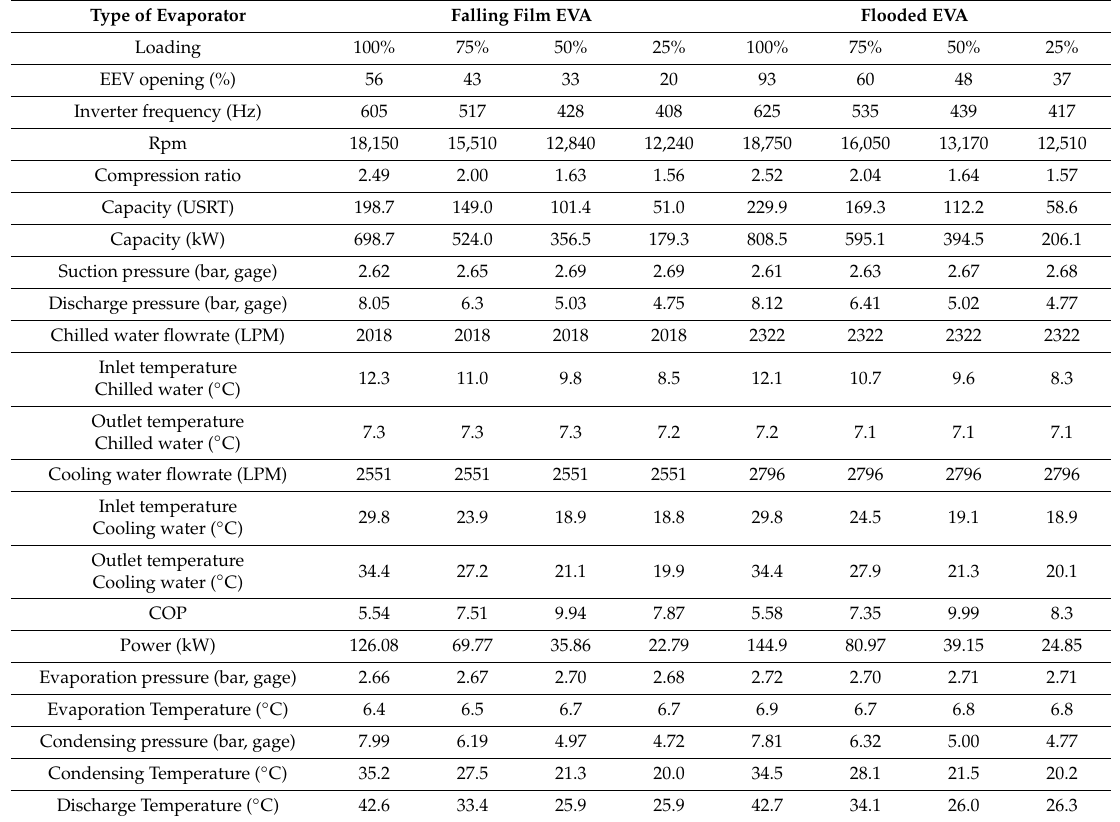
Table 1. Test results for the oil-free centrifugal chiller with a falling evaporator and a flooded evaporator associated with full and partial